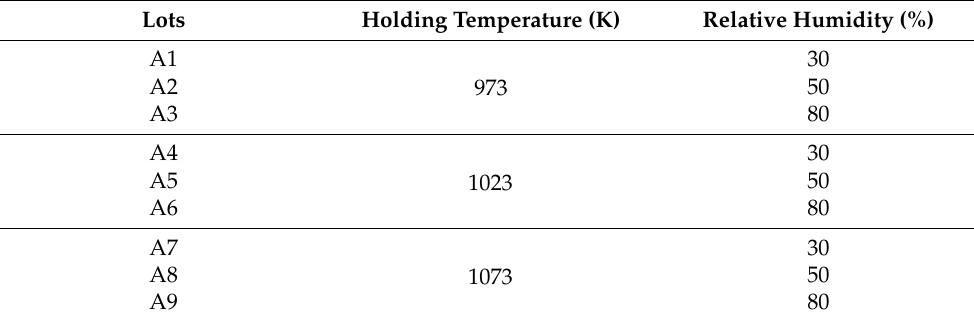
Table 2. The experimental arrangement.